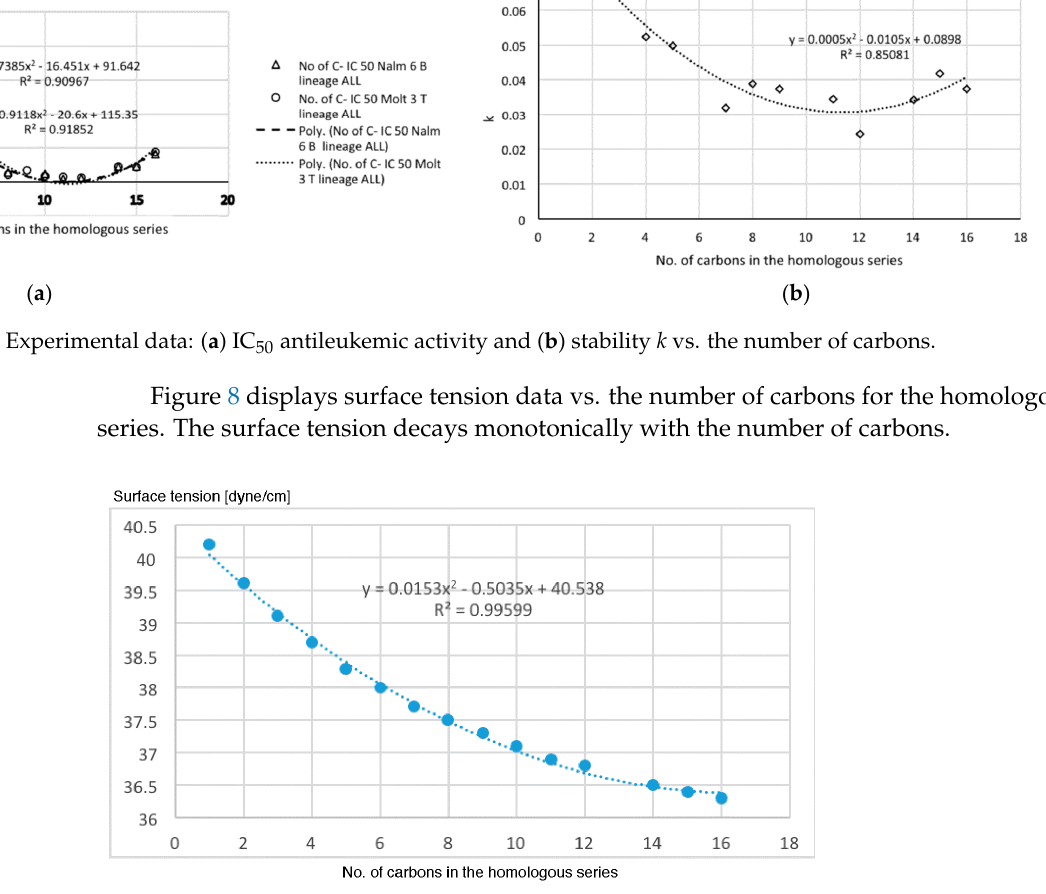
Figure 8. Surface tension data vs. the number of carbons.